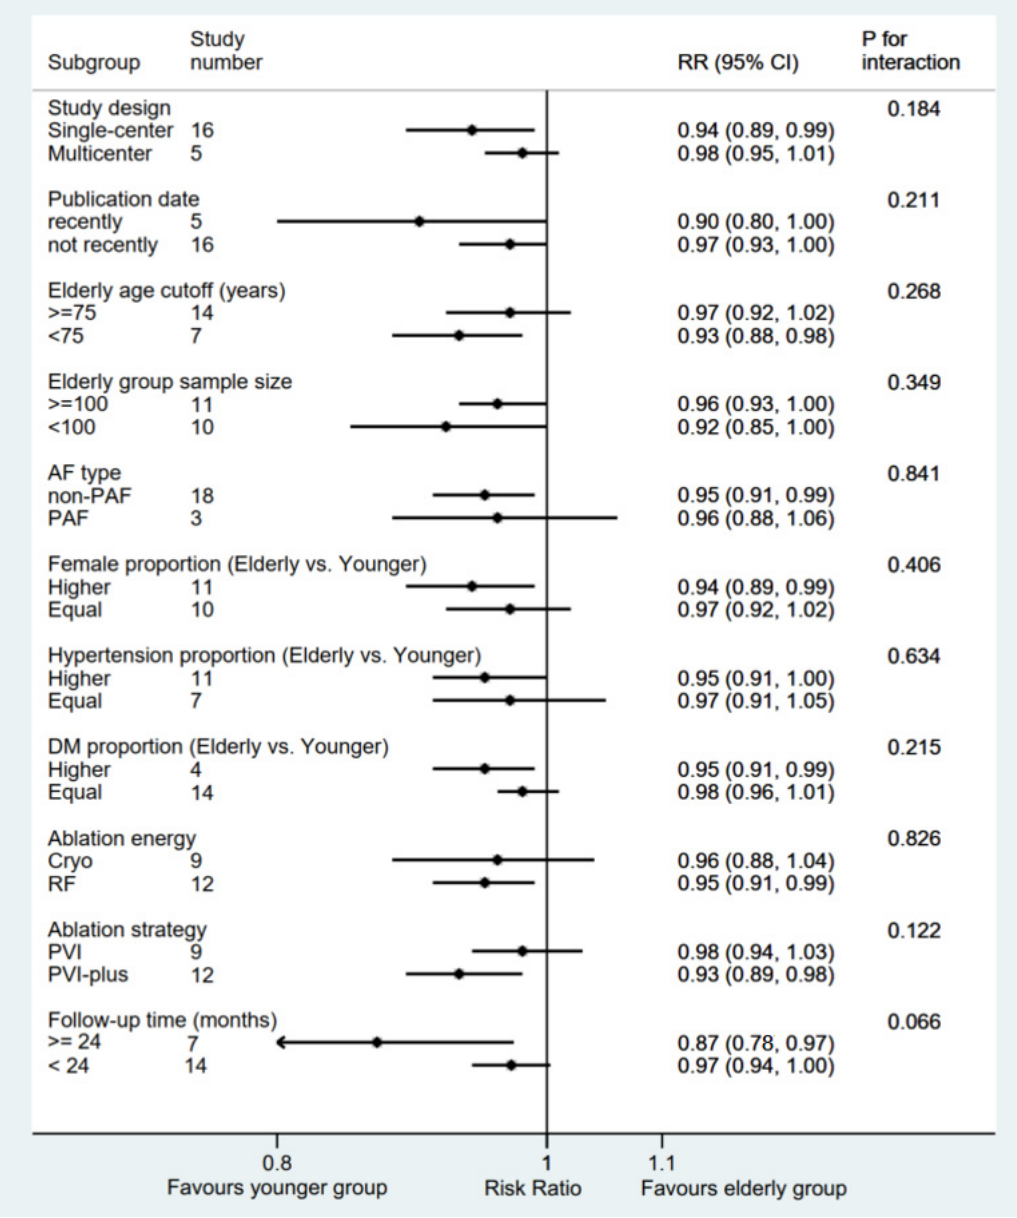
Figure 3. Forest plot of subgroup analysis of the freedom rate from AF between elderly and younger groups. Subgroup analysis of the rates of freedom from AF between elderly and younger groups. AF: atrial fibrillation; PAF: paroxysmal atrial fibrillation; RF: radiofrequency; Cryo: cryoablation; PVI: pulmonary vein isolation; PVI-plus: PVI plus linear and/or substrate ablation.